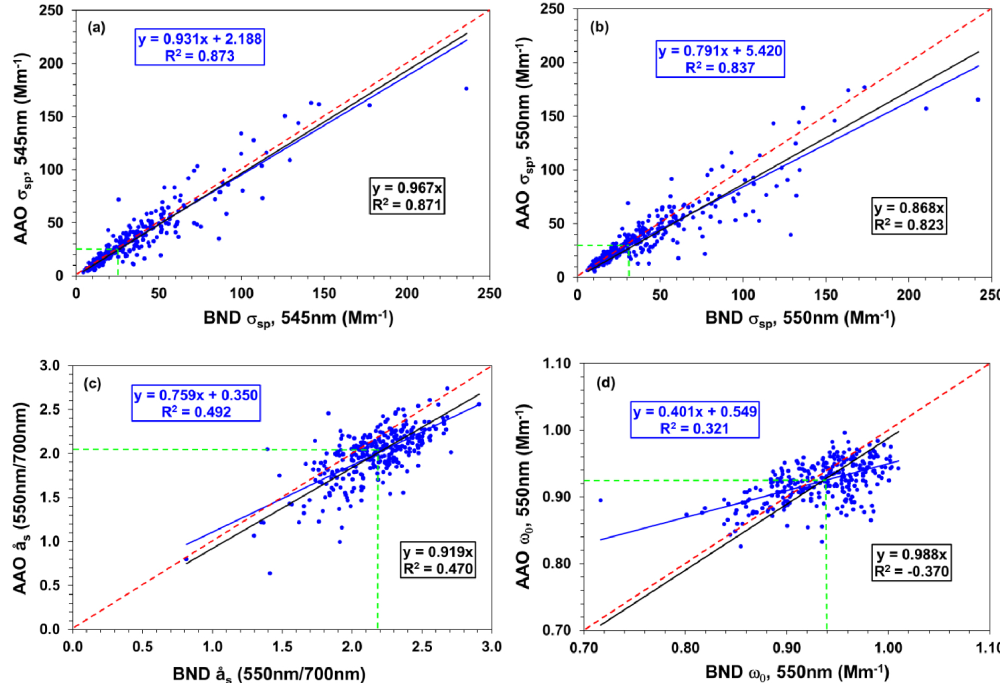
Fig. 6. Comparisons of BND surface aerosol data with concurrent AAO flyby data. Data points represent 5-min AAO low-level flight segment averages over the BND site vs. two-hour BND surface data centered on the flyby time. (a) σ sp for D p < 1µm particles. (b) σ sp for “total” size cut particles. (c) ˚a s for “total” size cut particles. (d) ω 0 for “total” size cut particles. Red dashed line = 1:1, green dashed lines show the median values for each population, and blue and black solid lines show the linear regression fit lines (black forced through the